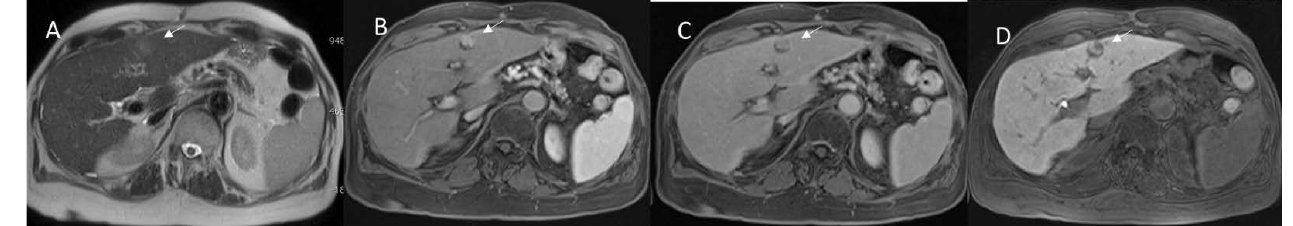
Figure 2. HCC EOB-MRI assessment. The lesion shows (arrow) hyperinthense signal on T2-W: ( A ) sequences, ( B ) arterial hyperenanchement during arterial phase of contrast study, ( C ) wash-out appearance during portal phase, and ( D ) hypointense signal during hepatospecific phase.